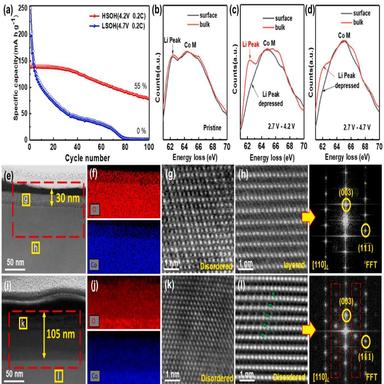
Electrochemical performance and microanalysis of the LCO sample with different SOH. (a) Capacity retentions of the pristine LCO after 100 cycles at 2.7–4.2 V, and 2.7–4.7 V, respectively. (b-d) EELS results of the pristine LCO, the HSOH, and the LSOH samples, showing the difference in lithium concentration at the surface and in the bulk. (e, f) STEM HAADF image of the HSOH sample and its corresponding EDS elemental mapping (Co, O). (g, h) High-resolution STEM HAADF images from the surface (g) and bulk (h) o